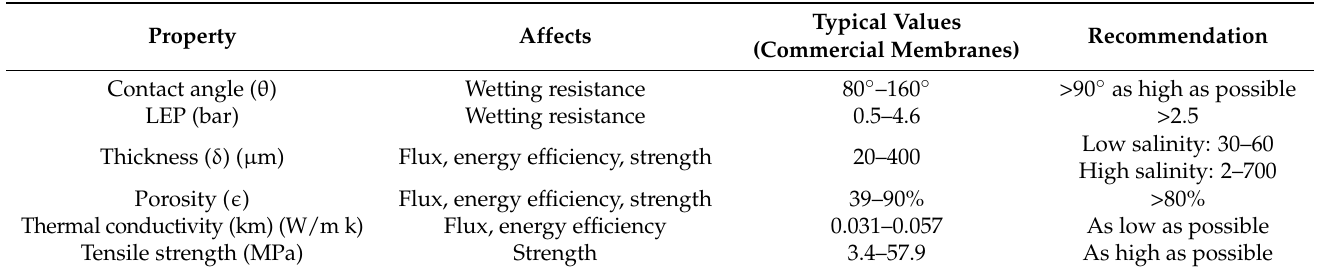
Table 1. Desired values for the properties of the membranes used in the MD process. Adapted from